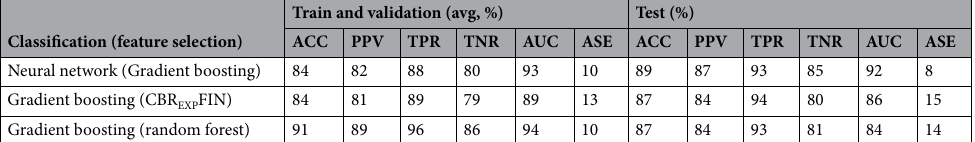
Table 6. Detailed metrics for the three best performing classifiers for CBR data.